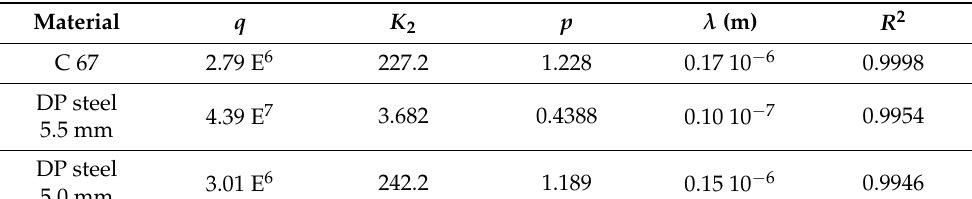
Table 3. Fitting parameters of Equation (4), calculated dislocations mean free path, and accuracy of the interpolation expressed via R 2 .